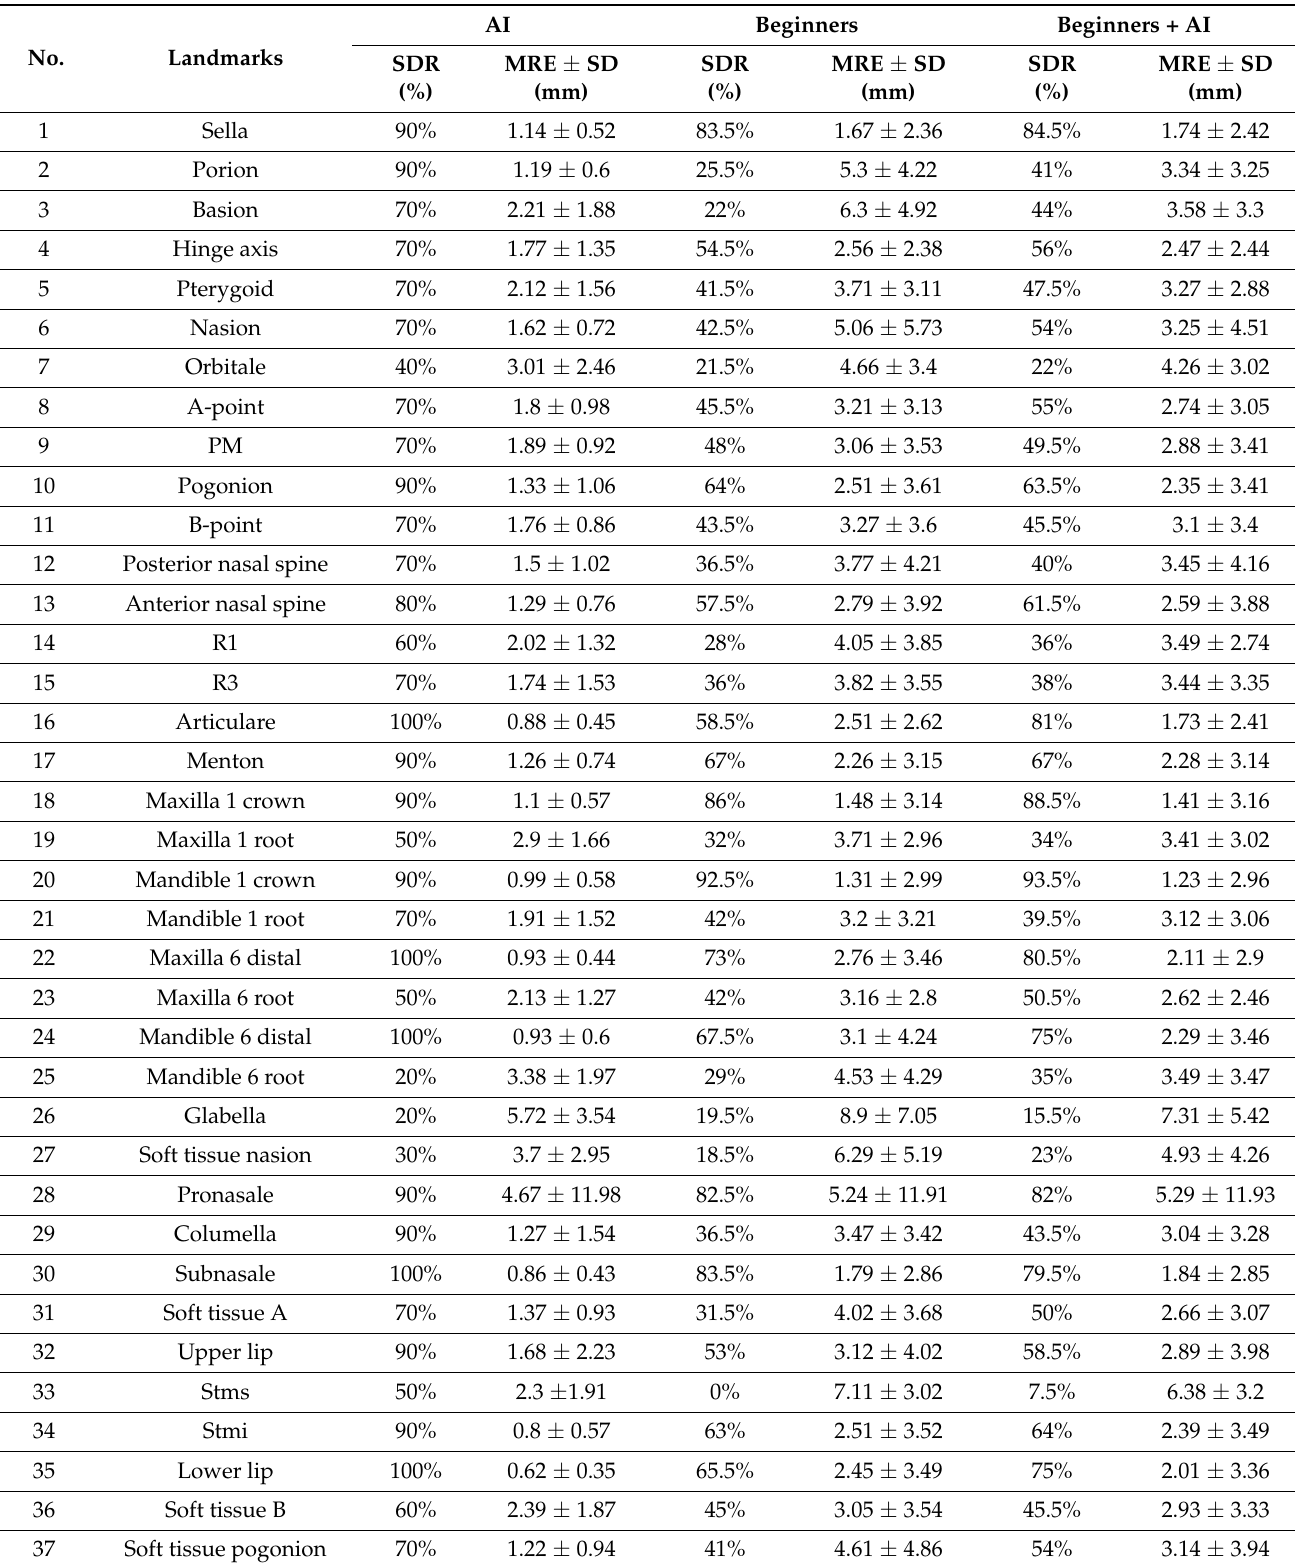
Table 5. Successful detection rate and mean radial error for each landmark within a 2 mm